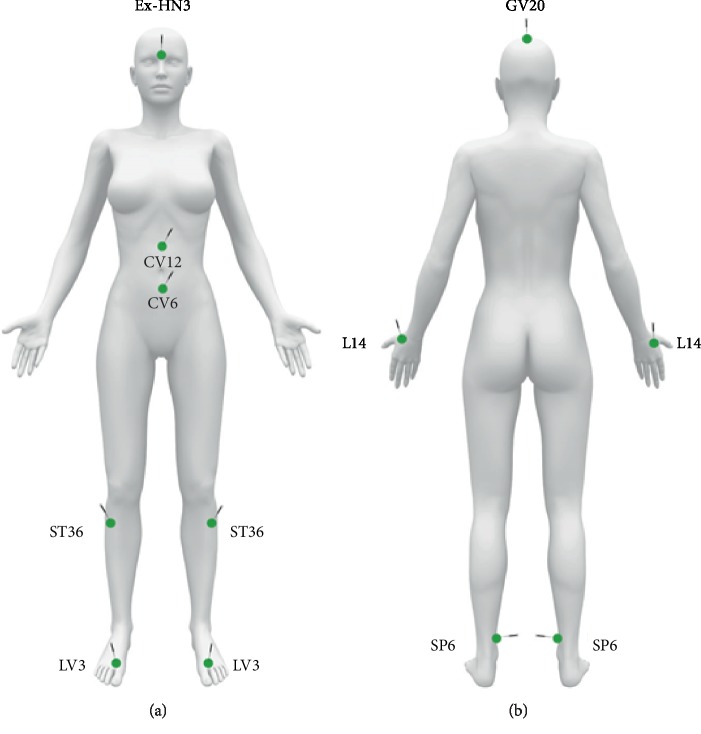
Manikin with the visual description of the location of acupuncture points used in this study.